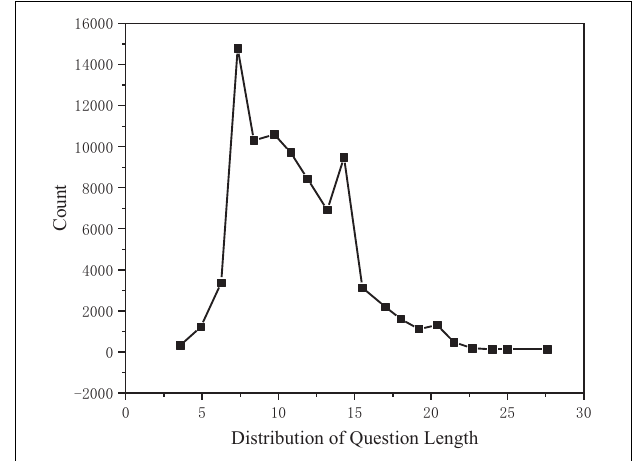
FIGURE 5 | Problem length distribution.